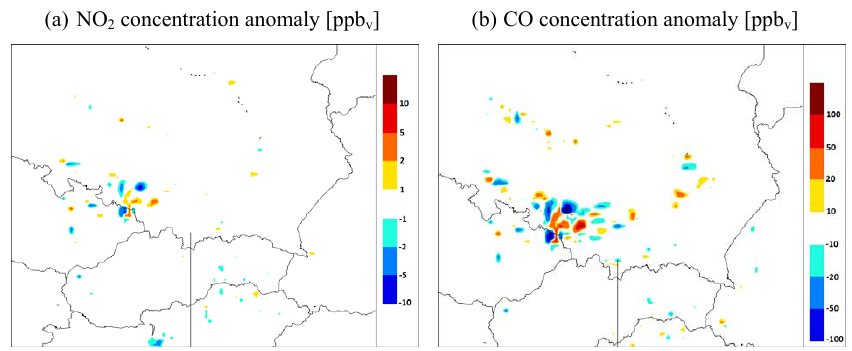
Figure 8. NO 2 (a) and CO (b) concentration anomalies calculated as the difference between urban and non-urban scenarios in the lowest model layer– 3 rd of January 2011, 12 UTC